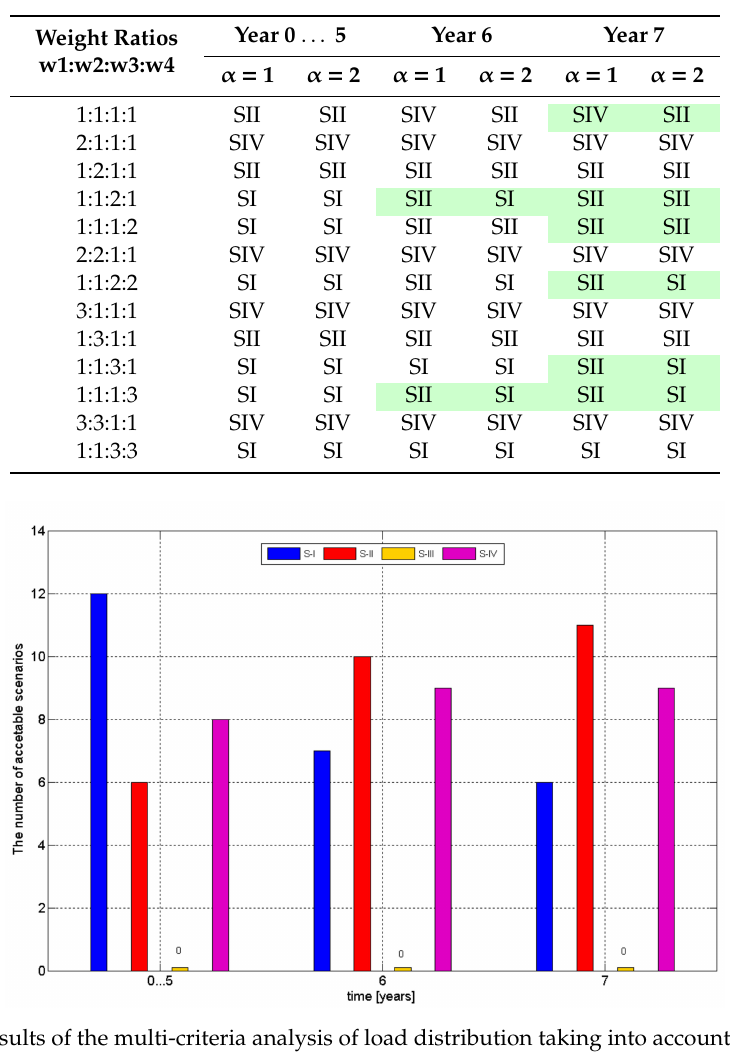
Table 6. Results of the multi-criteria analysis of load distribution taking into account a decrease in the performance of the fuel cell only in the time of exploitation.